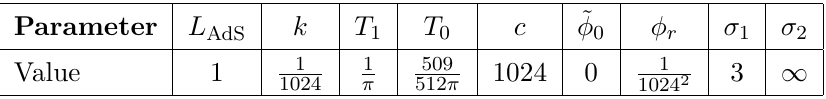
Table 1. The numerical values of the various parameters that are used to produce the plots in figures 6 and